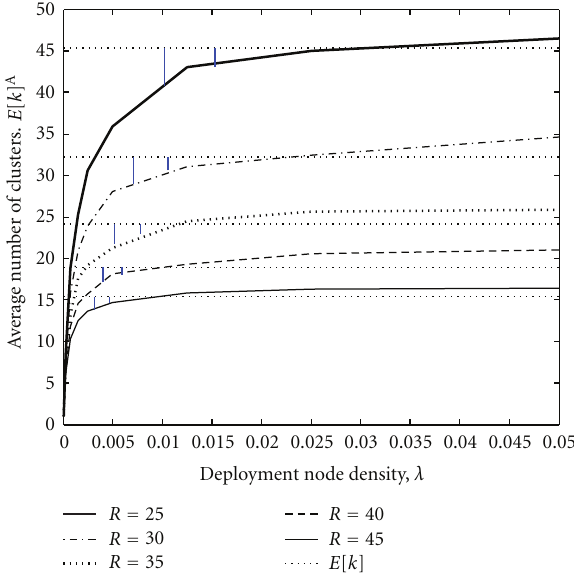
Figure 6: “ E [ k ] A versus λ ” for di ff erent R : 200 × 200m 2 square deployment